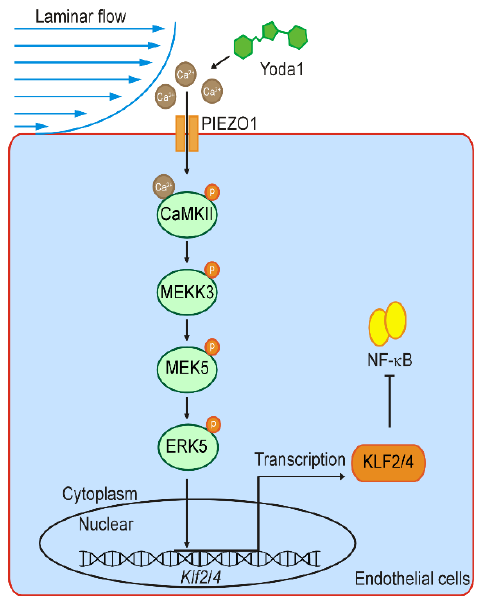
Figure 7. Schematic diagram shows the shear stress-induced KLF2/4 expression via PIEZO1/CaMKII/MEKK3/ERK5 cascade. Laminar flow stimulates the activation of PIEZO1 and thus causes Ca 2+ influx, which further activates CaMKII. Cascade phosphorylation of MEKK3/MEK5/ERK5 is induced by the activation of CaMKII and ultimately leads to Klf2 and Klf4 transcription. Elevated KLF2/4 inhibits NK-κB to exert anti-inflammatory effect in the endothelium response to laminar flow.